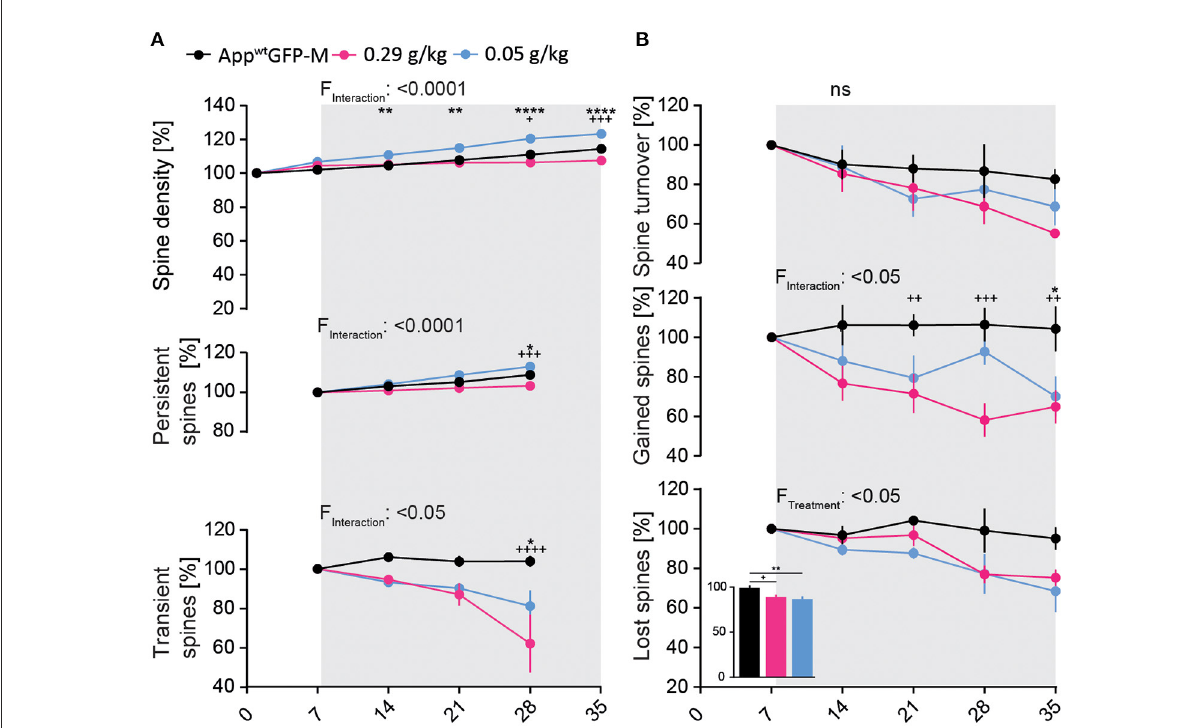
FIGURE4 BACE1-inhibition affects spine kinetics and density in App wt GFP-M mice of hippocampal dendrites in a dose-dependent manner. (A) A significant decrease in spine density was observed in App wt GFP-M mice with high-dose NB-360 treatment (0.29 g/kg), while a significant increase was observed with low-dose NB-360 treatment (0.05 g/kg) ( p TW < 0.0001). This effect is reflected in the dose-dependent treatment effect on the fraction of persistent spines ( p TW < 0.0001) as well as on the fraction of transient spines ( p TW = 0.0172). (B) NB-360 treatment at high and low doses significantly decreased the formation of new spines ( p TW = 0.0132) as well as the fraction of lost spines ( p TW = 0.0356). This effect was more pronounced with low-dosed NB-360 treatment than in high-dose and vehicle treatment groups ( p OW = 0.0039). The effects on spine turnover rate did not reach significance. N = 6 animals per group, n = 7–10 dendrites per animal. Data are presented as mean ± SEM. Bonferroni post-hoc test results: * / + p TW / OW < 0.05, ** / ++ p TW / OW < 0.01, +++ p TW / OW < 0.001, **** / ++++ p TW / OW < 0.0001, p TW from two-way ANOVA and p OW from one-way